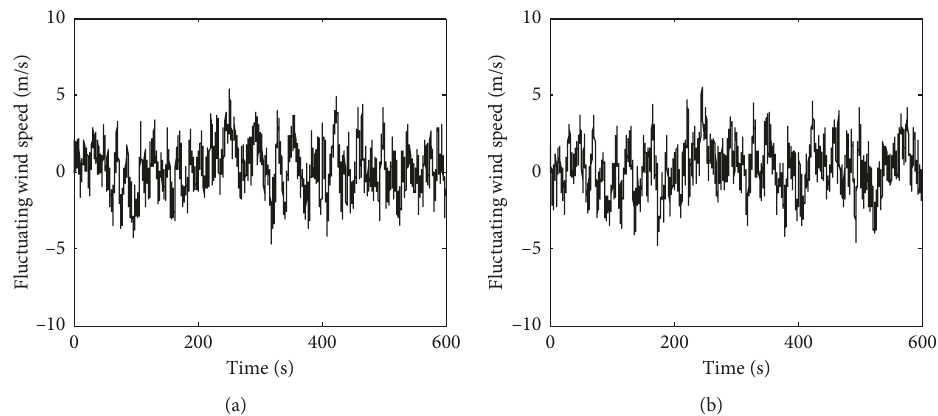
Figure 1: Simulated fluctuating wind speed on the (a) fifth floor and (b) tenth floor.